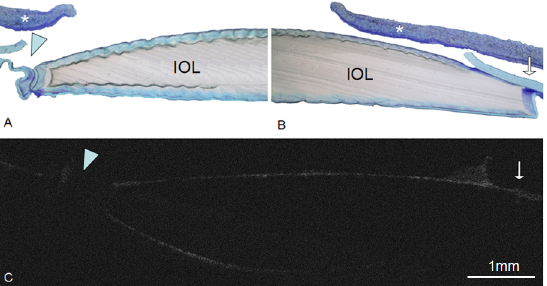
Fig 4. Histopathological section observations on day 11 postoperatively and OCT images on day 7 postoperatively at the scan position. (A) Unformed capsular bend configuration at temporal side (blue triangle). (B) Anterior adhesion type at nasal side (white arrow). (C) OCT image of the same rabbit showing the same capsular bend configuration at the same place. The white asterisk indicates the